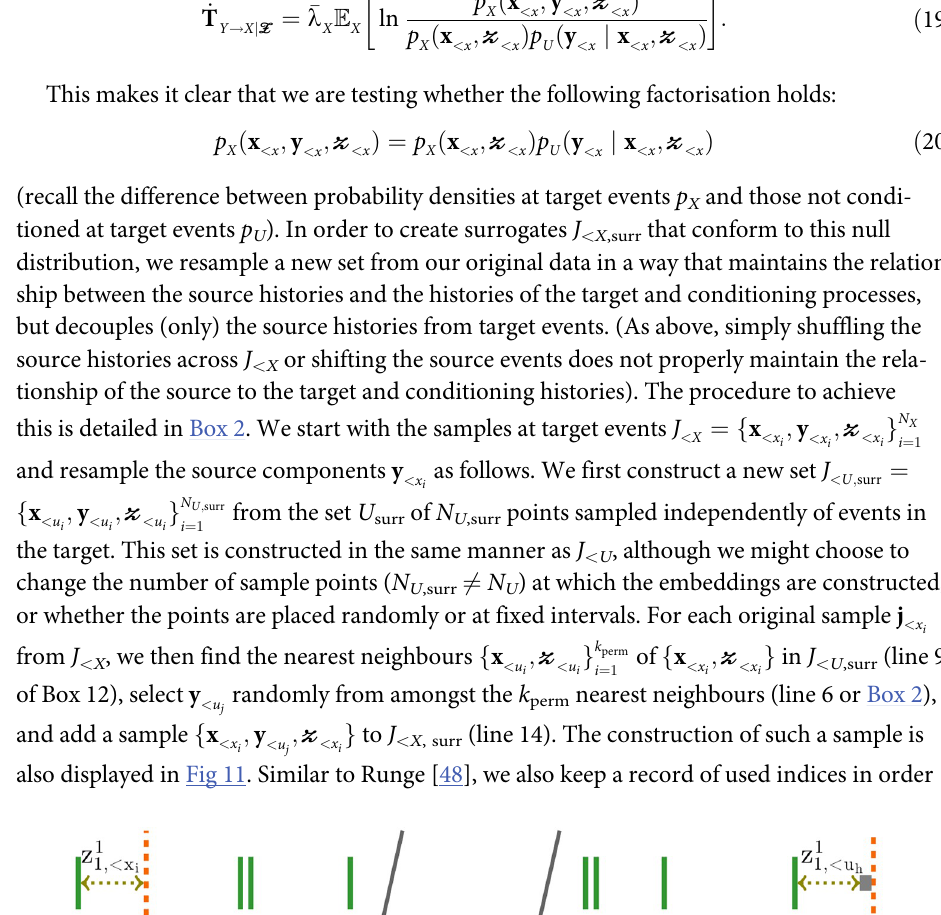
is similar to the x < x i